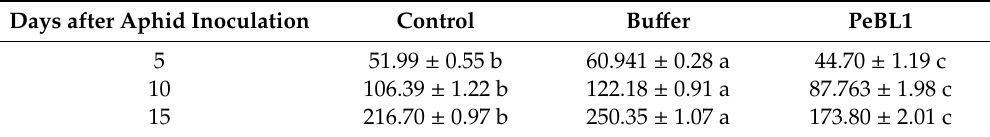
Table 2. Developmental time, reproduction capacity, and increase of the intrinsic rate of M. persicae in PeBL1-treated and control seedlings of